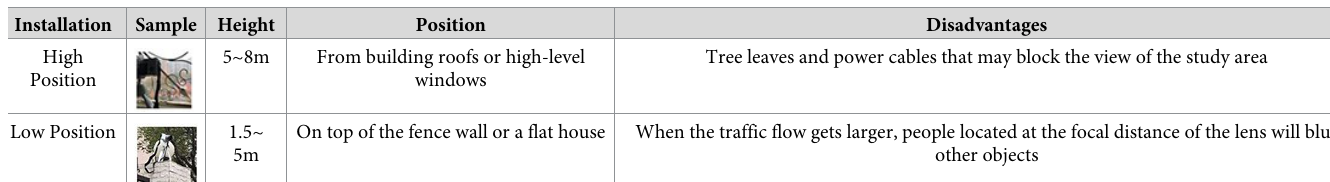
Table 2. Installation type of photographic